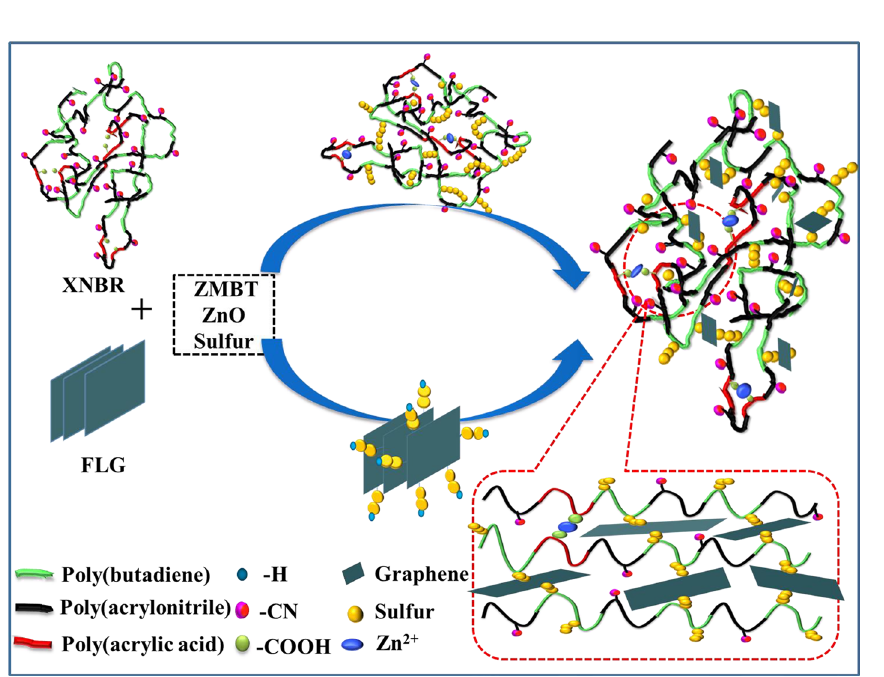
Figure 10. Illustration of formation of the covalently edge linked XNBR-FLG nanocomposites via